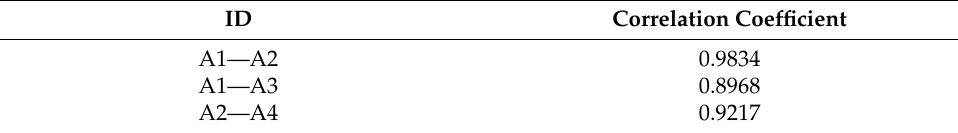
Table 5. SCADA wind speed correlation coefficients of four wind turbines.